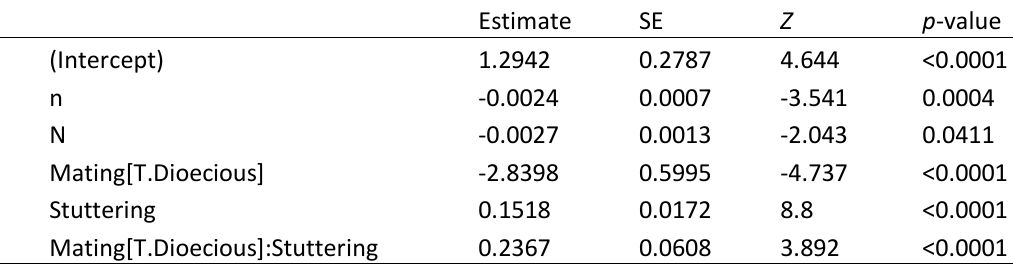
Table 2: Summary of the generalized linear mixed model for the number of loci found with a significant stuttering (response variable) with the new alternative multi-subsamples method. Explanatory variables were: n (number of subpopulations), N (subpopulation size), mating system (dioecious pangamy or monoecy with 30% selfing) and stuttering intensity (0 or 10%). In case of qualitative variables (mating system), the modalities with least positive effects are compared to the one with the most positive